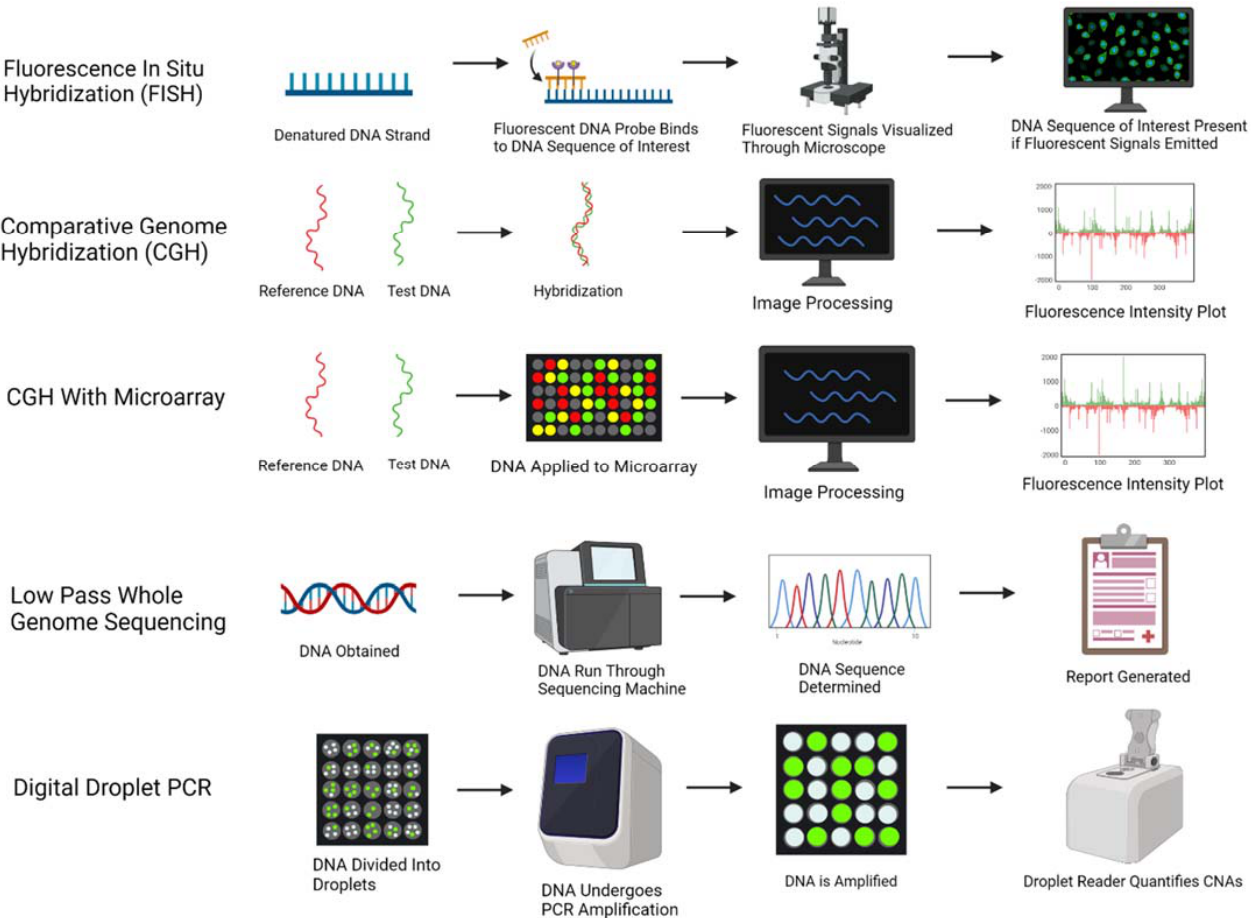
Figure 1. Various methods to characterize and quantify copy number alterations are illustrated: fluorescence in situ hybridization (FISH), comparative genome hybridization (CGH), CGH with mi- croarray, low pass whole genome sequencing, and digital droplet PCR. Created with BioRen ‐ der.com.